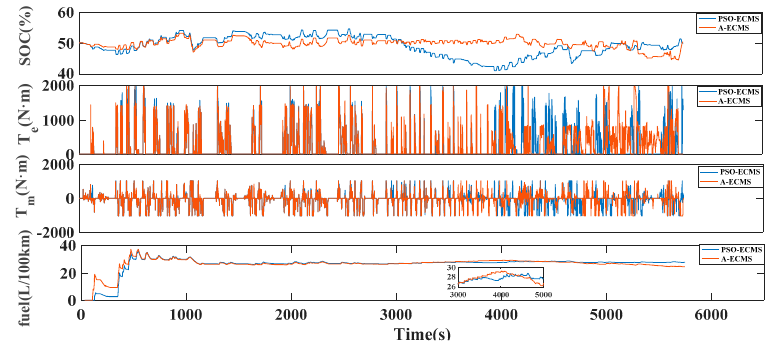
Figure 20. The simulation results of PSO-ECMS and A-ECMS under composite cycle.